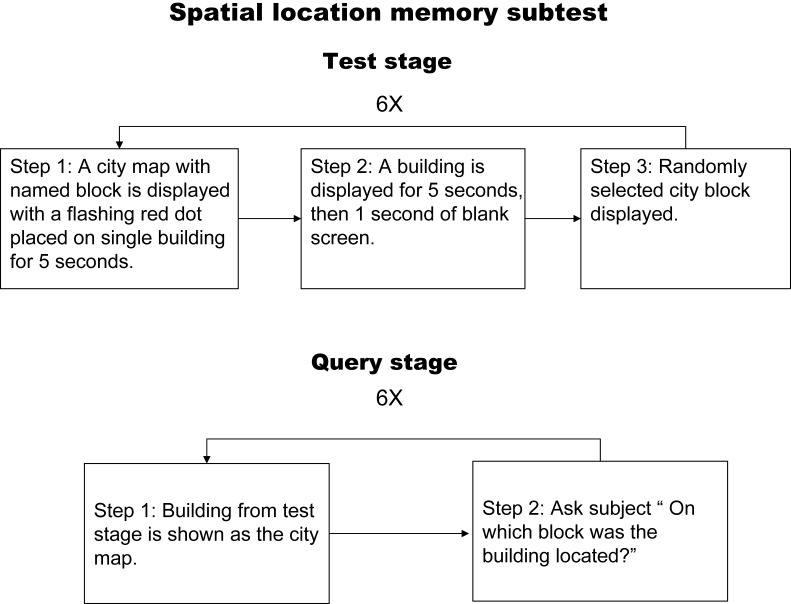
Flow chart illustrating the spatial context memory test.